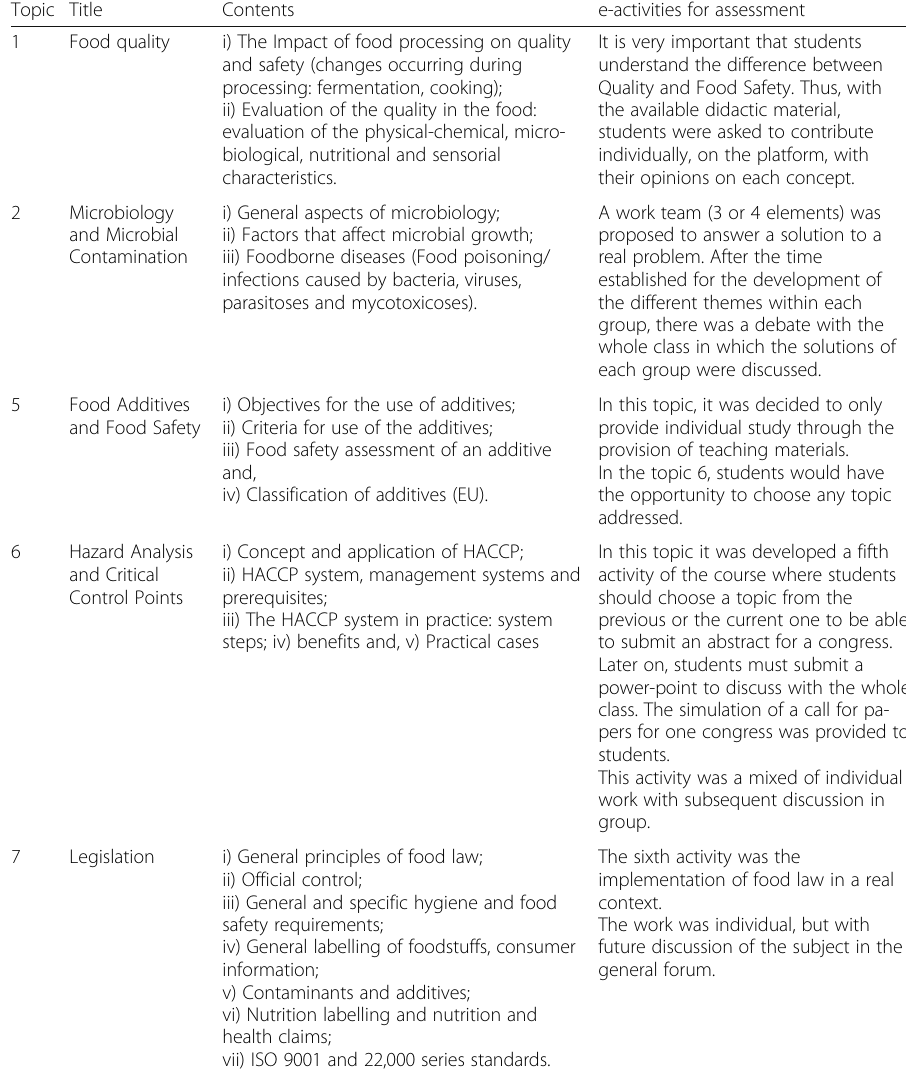
Table 1 Topics, titles, contents of course and development of e-activitie. Topics 3 and 4 (natural food toxins and contaminants) were not considered on this research (see methods chapter). These topics only account for 17% of the